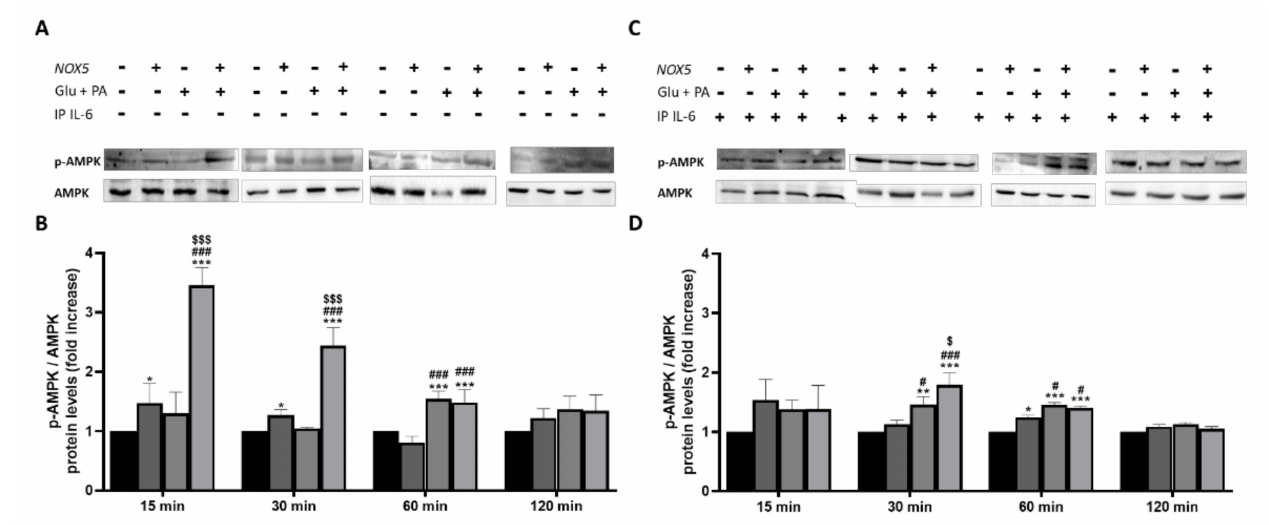
Figure 9. Phosphorylation levels of AMPK are increased in 3T3-L1 adipocytes when cultured for 15, 30 and 60 min with Glu + PA conditioned media from NOX5-expressing endothelial bEnd.3 cells ( A , B ). This increase is prevented when IL-6 is immunoprecipitated from the media ( C , D ). ( A , C ) Representative images of Western blots for p-AMPK and AMPK. ( B , D ) p-AMPK and AMPK protein levels of 3T3-L1 adipocytes ( n = 6). Results are expressed as mean ± SEM; * p < 0.05, ** p < 0.01, *** p < 0.001: differences relative to Nox5( − )/Glu + PA( − ); # p < 0.05, ### p < 0.001: differences relative to Nox5(+)/Glu + PA( − ); $ p < 0.05, $$$ p < 0.001: differences relative to Nox5( − )/Glu + PA(+); Statistical test used: